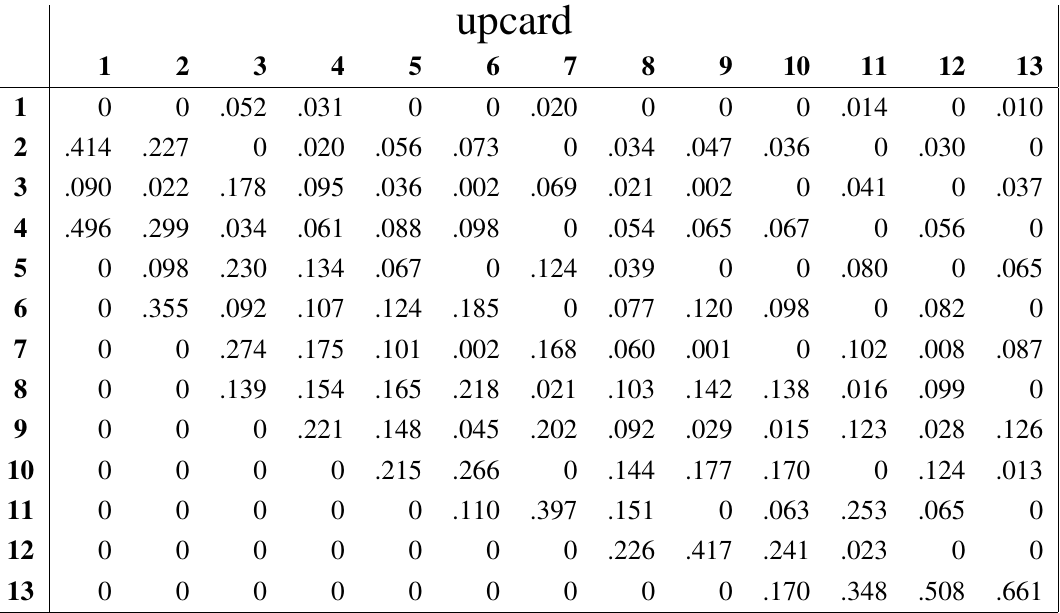
Table 2. Optimal strategy at the first move, N = 13